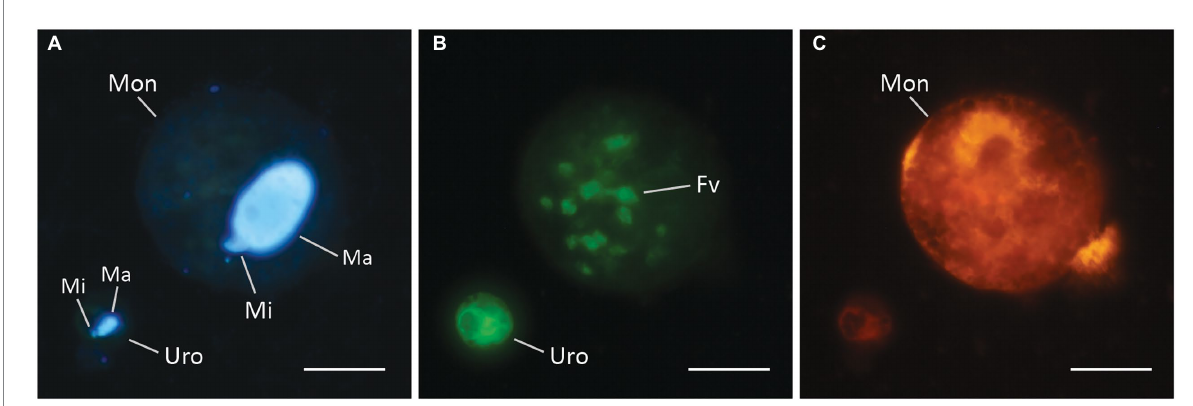
FIGURE 3 CARD-FISH photographs of double hybridization of the prey U. cf. pseudofurcata and its predator M. chlorelligerum . Photographs show the same area on the filter and were taken using different optical filters. DAPI-staining visualizing macro- and micronucleus of both ciliate species (A) , U. cf. pseudofurcata hybridized with Uro5-403 (B) , and M. chlorelligerum hybridized with MonoZH-179 (C) . In the left bottom corner of (B) an intact U. cf. pseudofurcata cell and inside the predator several ingested and largely digested cells and cell remains are shown. Different colors of hybridized cells derive from different dyes used for CARD-FISH. (Ma) Macronucleus, (Mi) micronucleus, (Mon) M. chlorelligerum , (Fv) food vacuoles with cell remains of U. cf. pseudofurcata , (Uro) U. cf. pseudofurcata . Scale bars = 20 μ